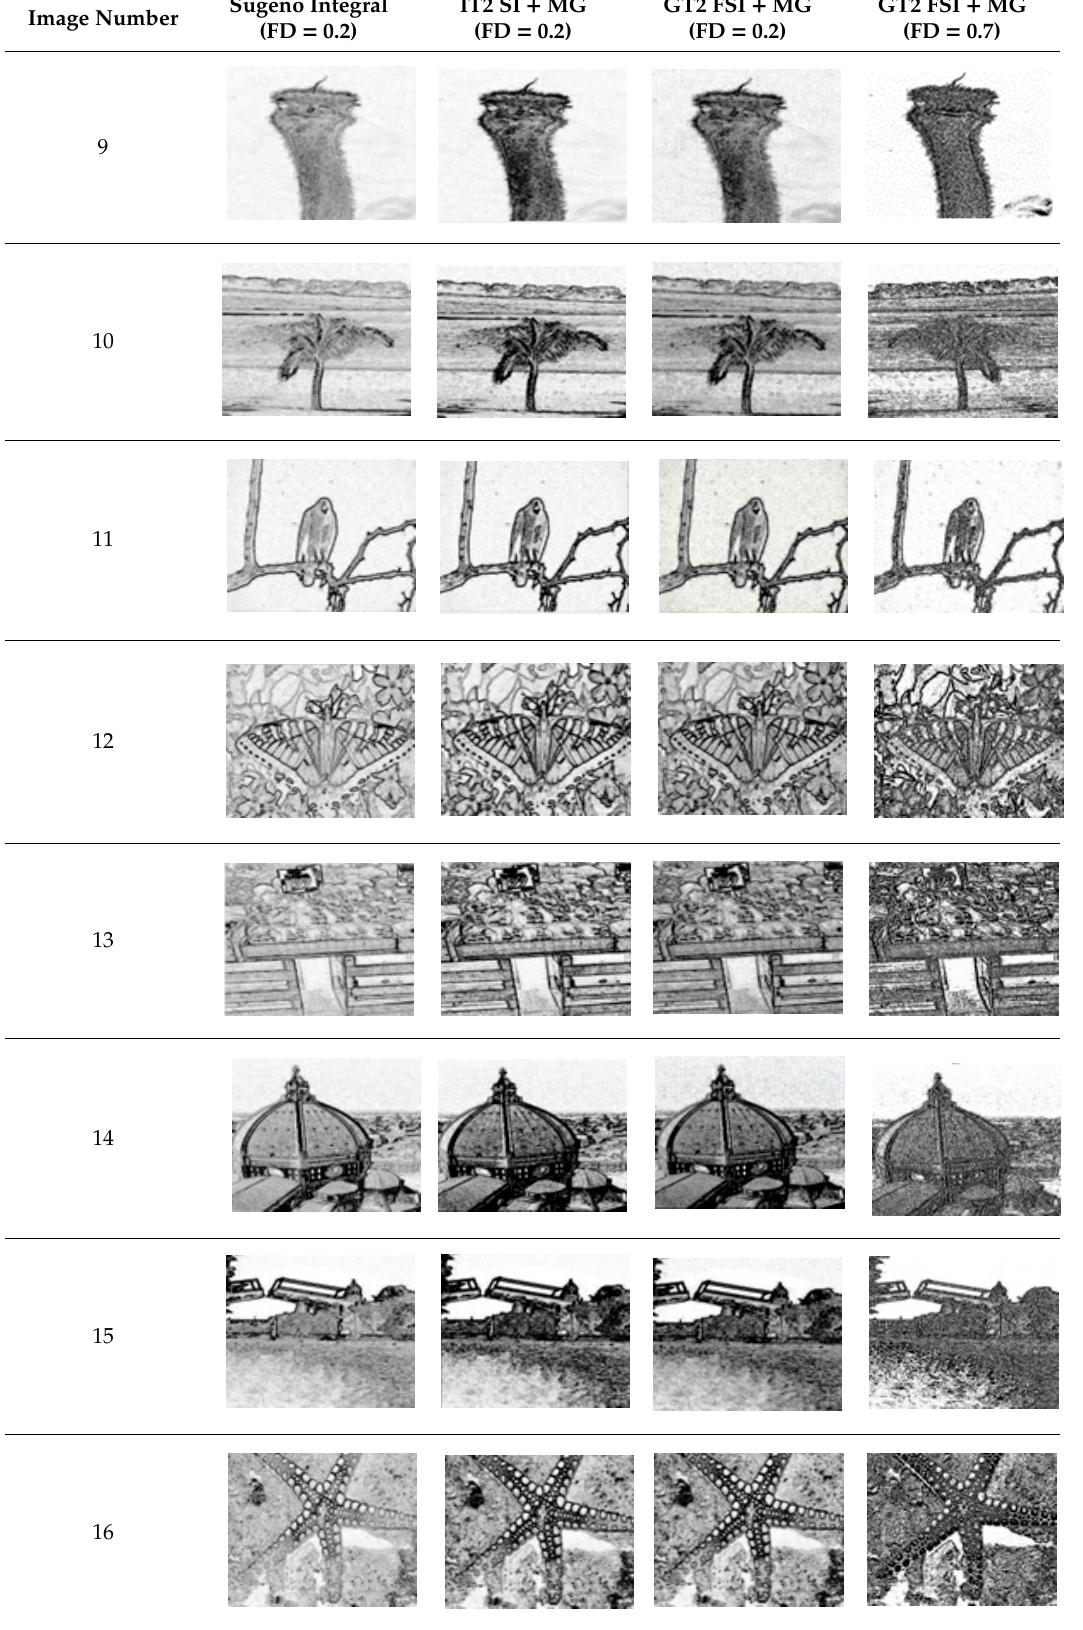
Table 12. FOM metric obtained after using edge detectors in the BSDS database. Image Number